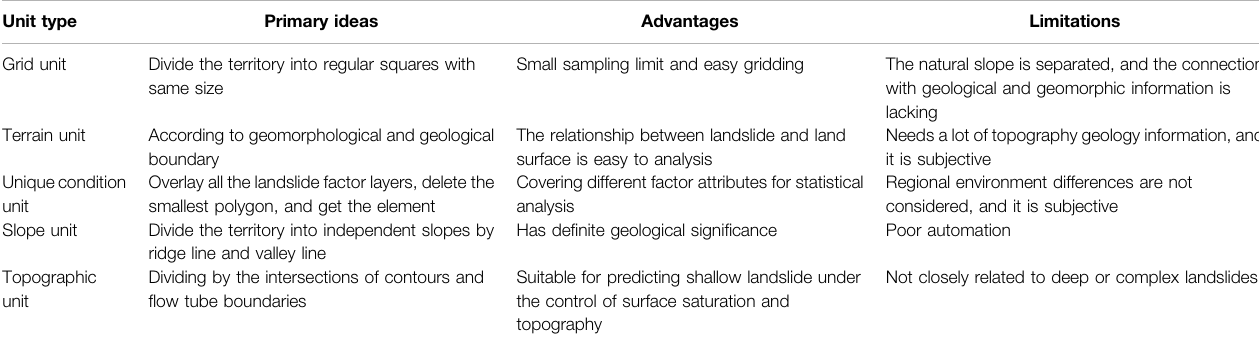
TABLE 1 | Classi fi cation and characteristics of different mapping